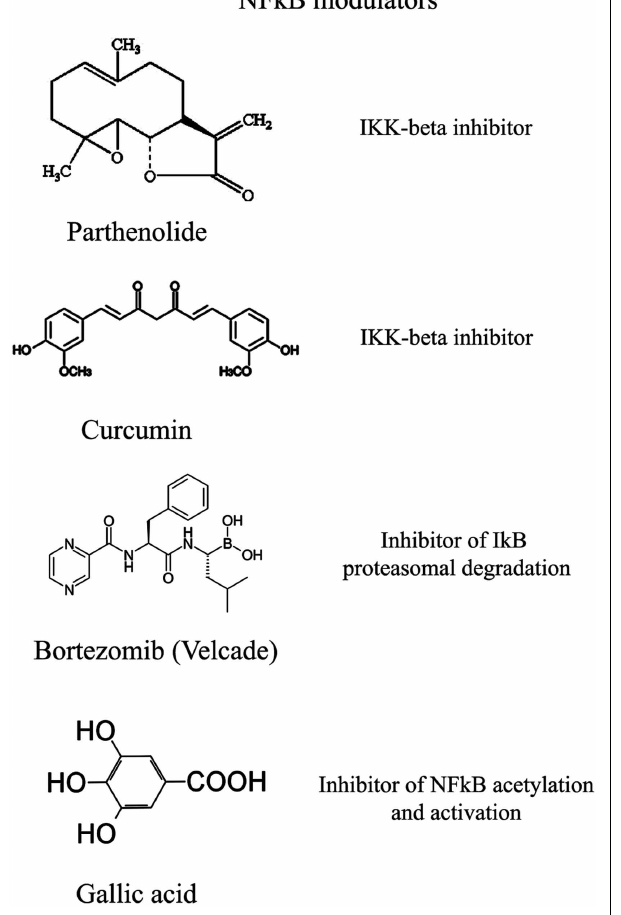
dehydroxymethylepoxyquinomicin (DHMEQ) that specifically inhibits NFkB nuclear accumulation with anti-inflammatory and anti-tumoral activity (Kozakai et al.,